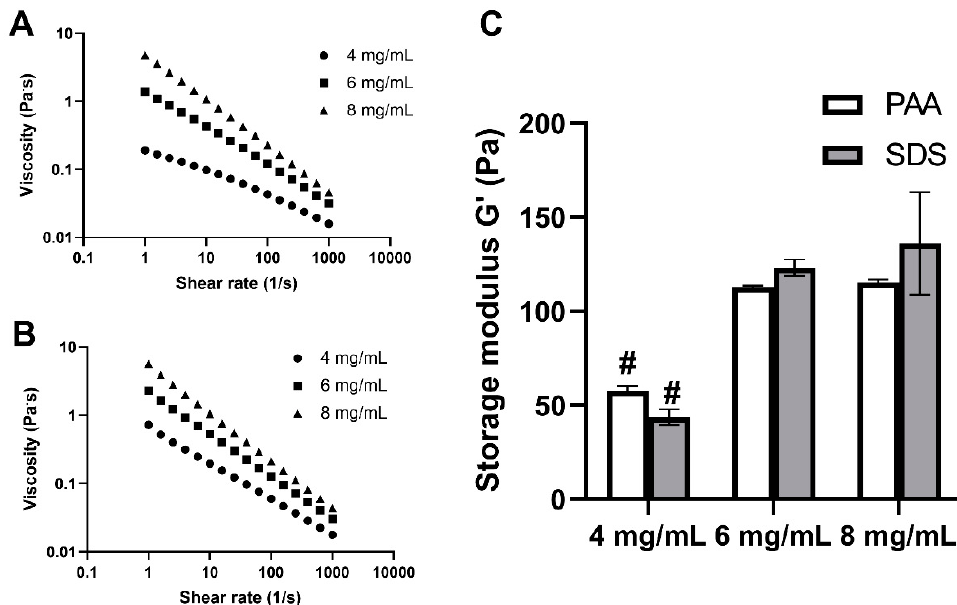
Figure 4. Rheological properties of UBM hydrogels. Viscosity of pre-gel solutions of PAA group ( A ) and SDS group ( B ). Storage modulus (G’) of hydrogels from PAA- and SDS-treated tissues ( C ). # denotes statistically difference from the 8 mg/mL concentration of the same decellularization group ( n = 3) ( p < 0.05).